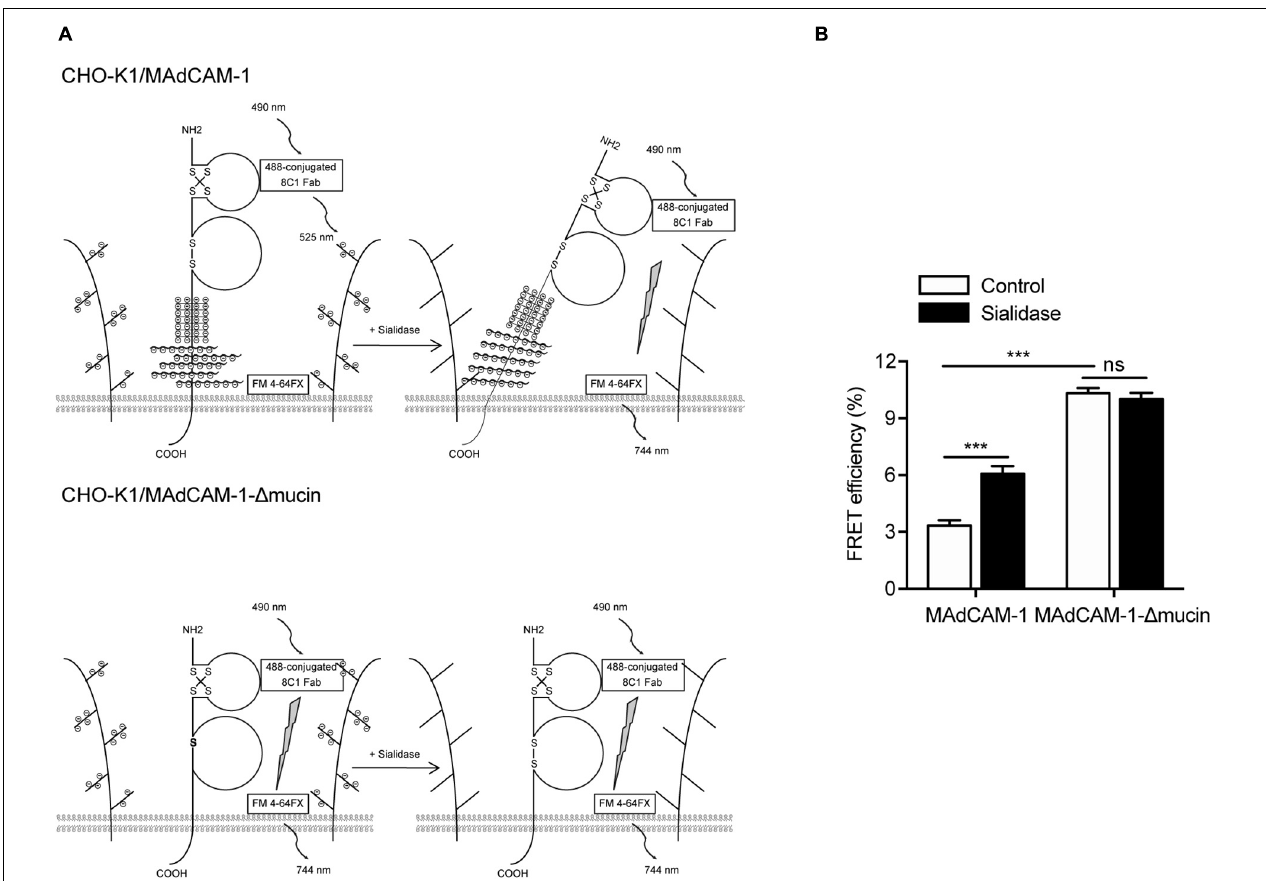
FIGURE 5 | Electrostatic repulsion between mucin-like domain and negative charges of the extracellular microenvironment affects the conformation of MAdCAM-1. (A) Experiment setup for measuring FRET efficiency between Ig-like-1 domain and the plasma membrane. A composite of all molecules used is depicted. (B) FRET efficiency of CHO-K1/MAdCAM-1 and CHO-K1/MAdCAM-1- (cid:49) mucin cells before and after treatment with sialidase. Data represent the mean ± SEM ( n ≥ 3). *** p < 0.001, ns: not significant (Student’s t